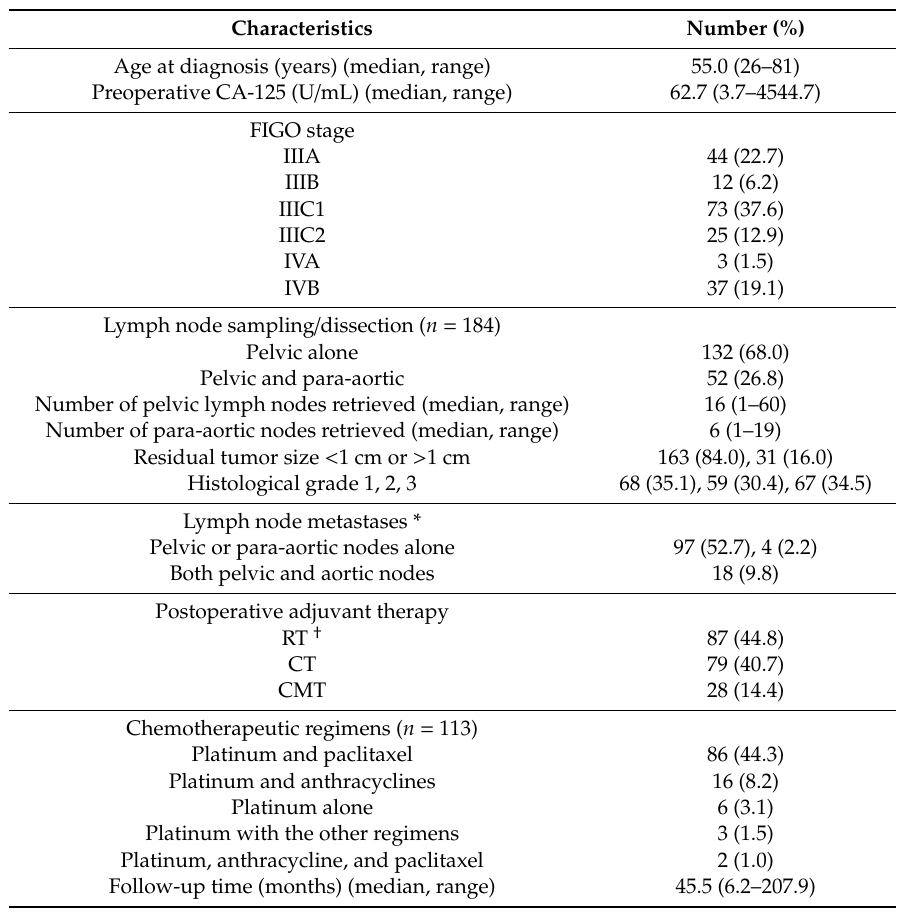
Table 1. Characteristic of patients ( n = 194) with advanced-stage endometrioid endometrial